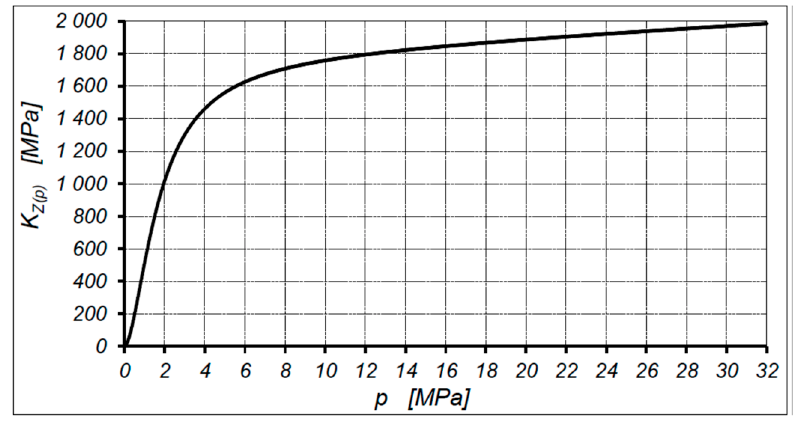
Figure 9. Characteristic K Z(p) = f(p) of oil Total Azolla 46 [12,28].